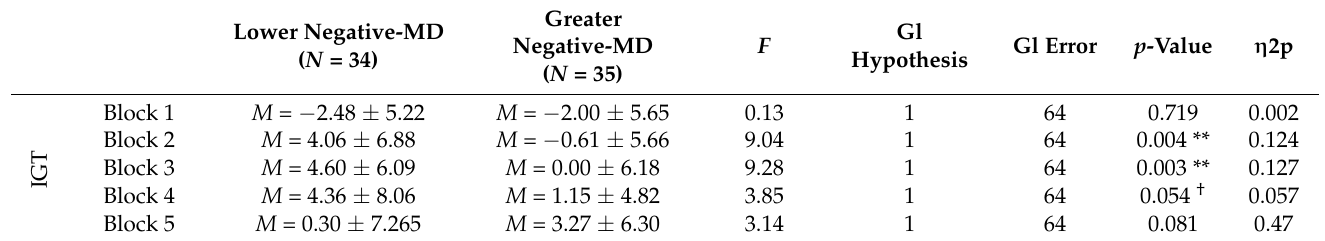
Table 1. Inter-subject effect tests for the different IGT